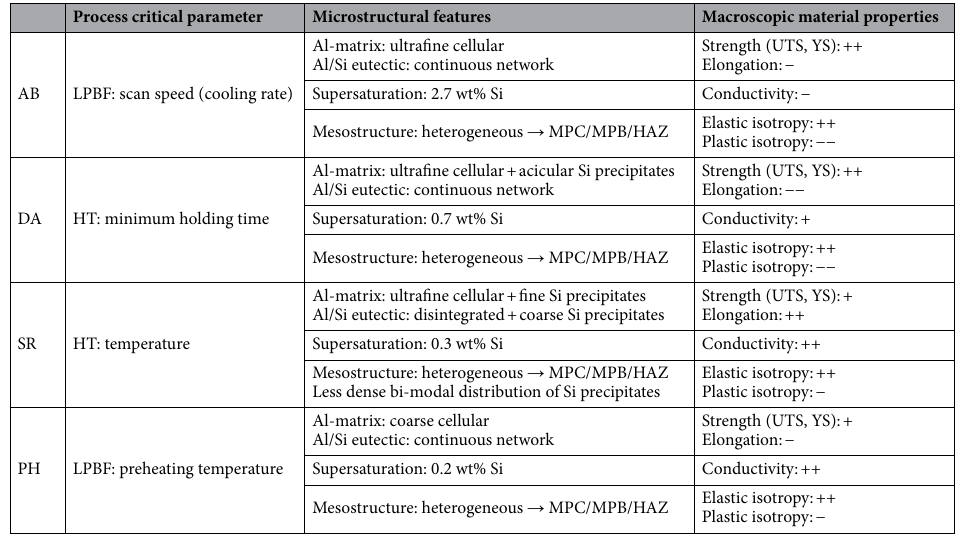
Process critical parameter Microstructural